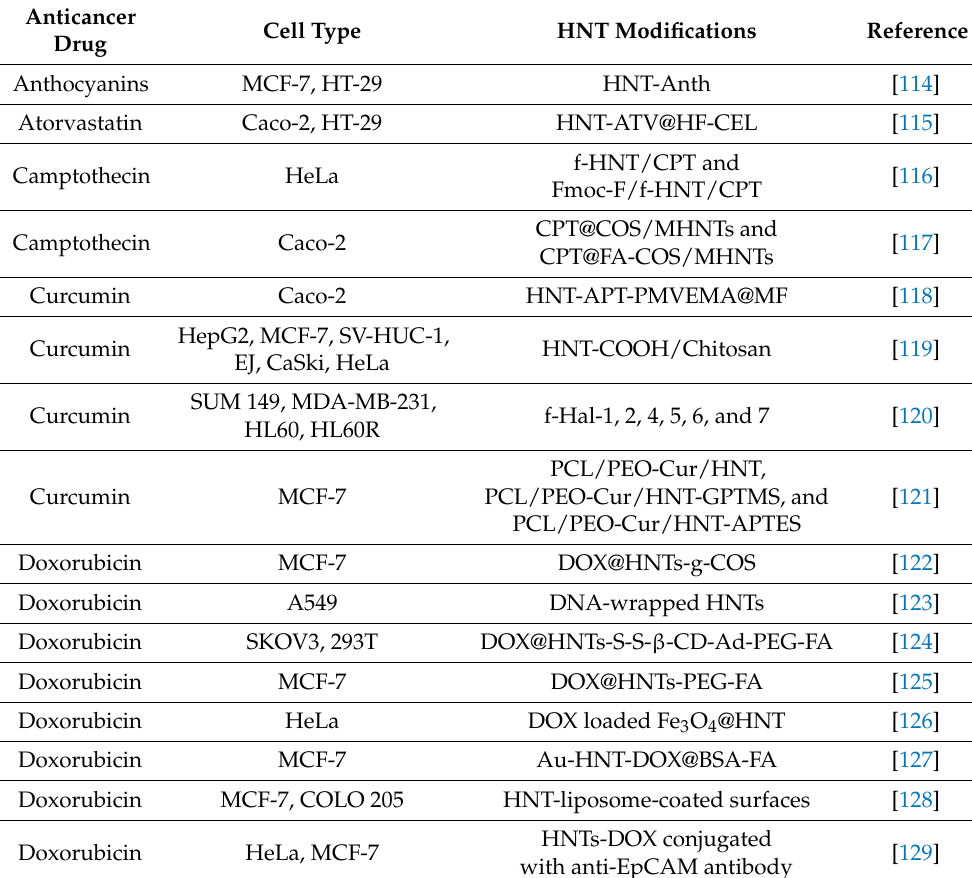
Table 2. HNT nanocomposites for controlled and sustained anticancer drug